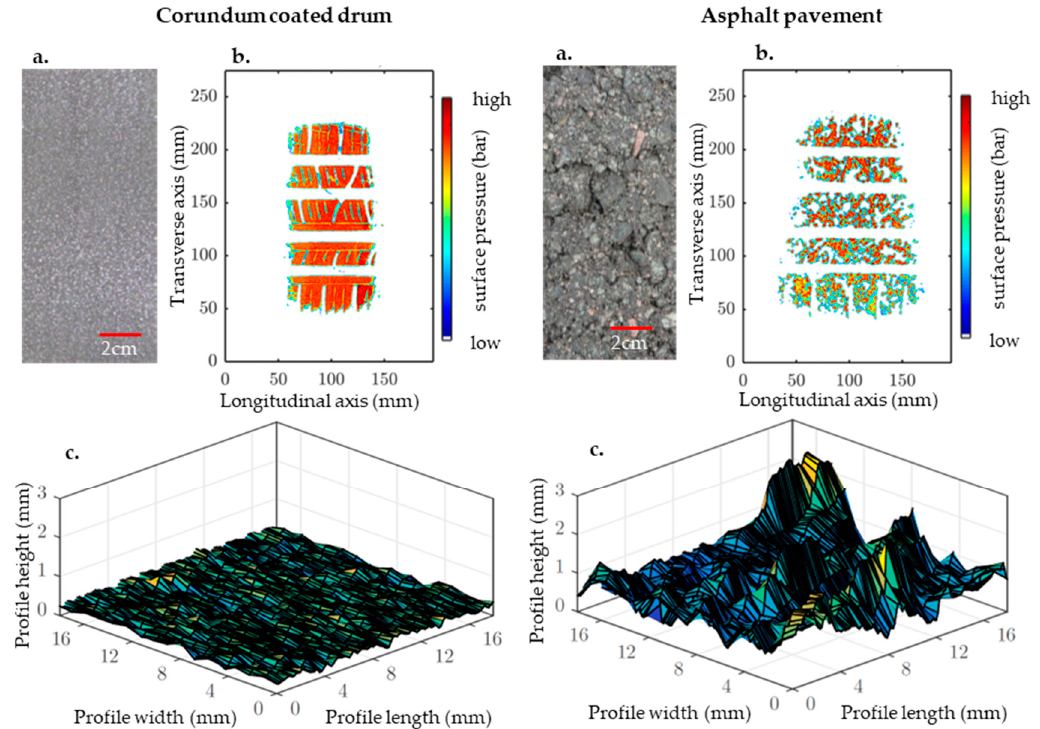
Figure 14. Comparison of the road surfaces ( a ) present on the single-roller test bench and in the real driving test with regard to the surface pressure distribution, ( b ) and the surface profiles, ( c ) at a tire inflation pressure of 2.5 bar.